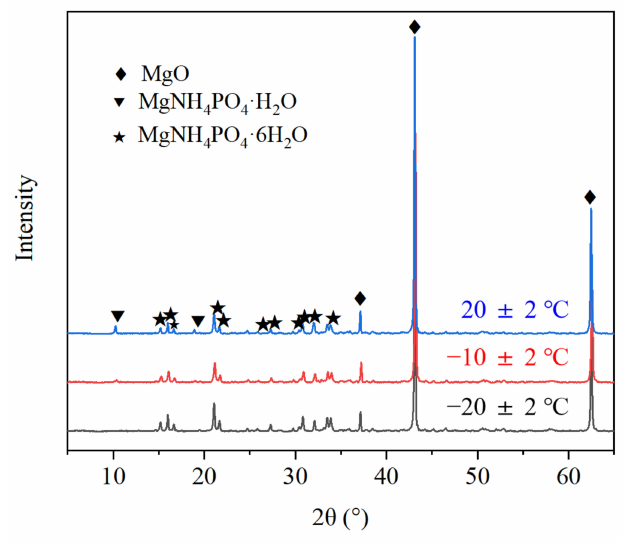
Figure 11. X-ray di ff raction (XRD) pattern of MPC (1 day) prepared at di ff erent